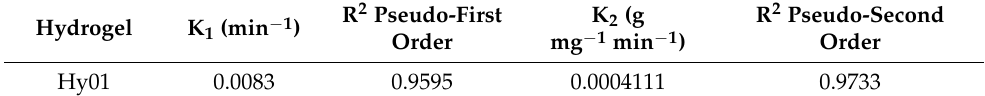
Table 4. The MO sorption data for the pseudo ‐ first and ‐ second ‐ order kinetic model.